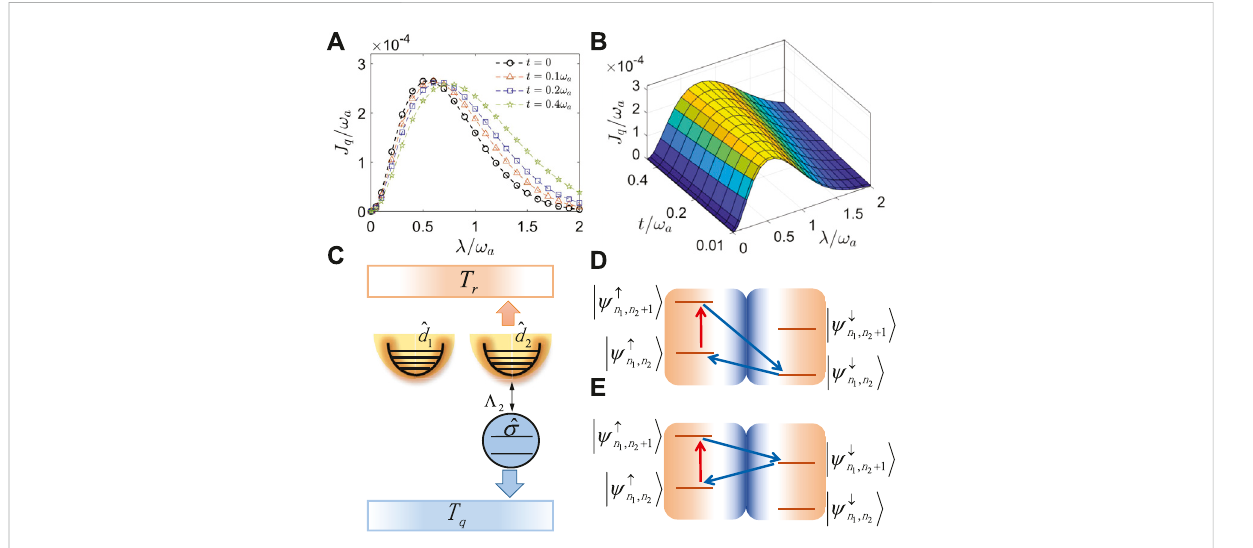
FIGURE 2 (Coloronline) (A) Steadystateheatcurrent J q / ω a asafunctionofthequbit-resonatorinteractionstrength λ / ω a ,withtypicalresonator-resonator couplings t / ω a . (B) Heat current J q / ω a as functions of λ / ω a and t / ω a . (C) Schematic illustration of the Hamiltonian at Eq. 3 with Λ 1 = 0. (D) and (E) are cycliccurrentcomponentsinEq.20aandEq.20b,respectively.Othersystemparametersaregivenby ε = ω a , λ 1 = λ 2 = λ , α 1 = α 2 =0.001 ω a , ω c =20 ω a , T r = 1.5 ω a , and T q = 0.5 ω a